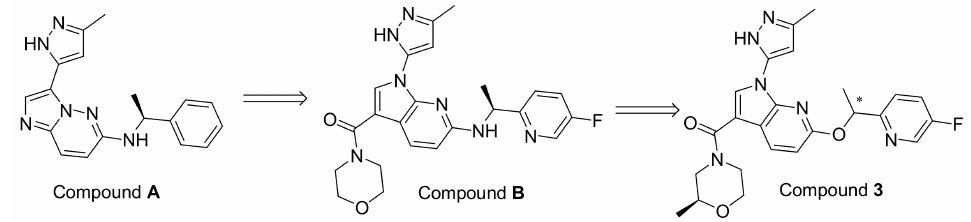
Figure 8. Cocrystal structure of compound A bound ALK protein. Different residues in ALK (green) and TrkA (yellow) around compound A (magenta) [12].